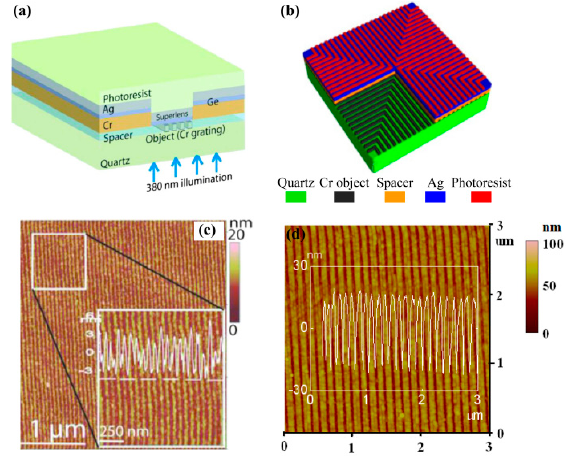
Figure 25. ( a , b ) are the schematic structures of a superlens; AFM image of resist pattern with half-pitch ( c ) 30 nm and ( b ) 60 nm. Reproduced from: (a,c) [101], Copyright © 2010, AIP; (b,d) [103], Copyright © 2012, ACS.